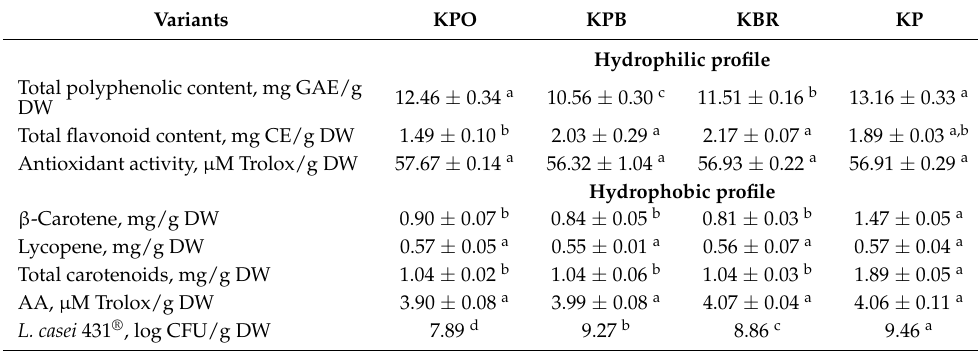
Table 2. Phytochemical characterization of freeze-dried